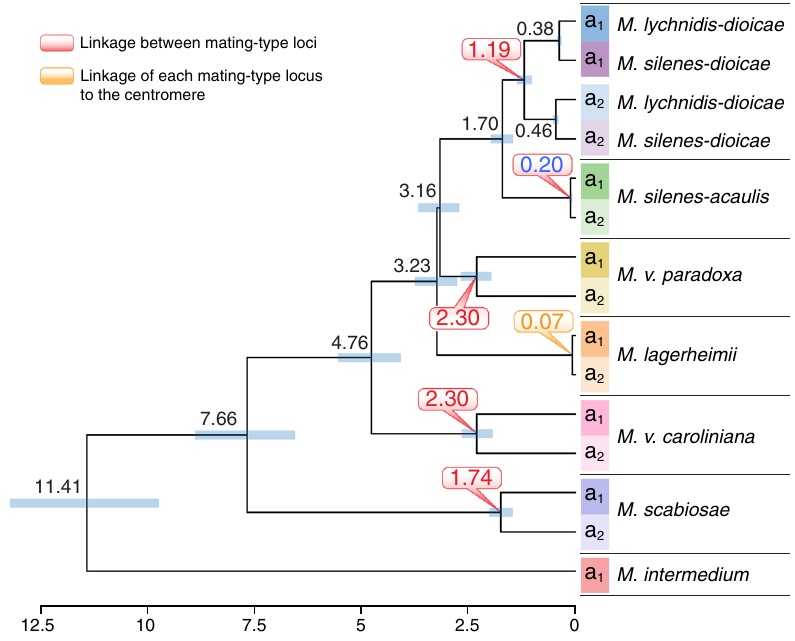
Fig. 4 Dates of mating-type loci linkage. Reconstructed phylogenetic tree based on 17 concatenated genes ancestrally located between the mating-type loci after chromosomal fusion in all the studied species with linked mating-type loci but M. silenes-acaulis and including alleles from both a 1 and a 2 genomes. Numbers on tree nodes indicate the inferred dates of speciation (in black) and the events of mating-type loci linkage, either one to each other or to their respective putative centromeres (in red and orange, respectively). The blue bars correspond to 95% con fi dence intervals. The scale at the bottom indicates the time before present (million years). None of the individual genes showed trans-speci fi c polymorphism, except between the sister species M. lychnidis- dioicae and M. silenes-dioicae (Supplementary Fig. 3). We used a restricted set of 13 genes (Fig. 3) for estimating the M. silene-acaulis mating-type loci linkage because not all 17 genes were located in its non-recombining